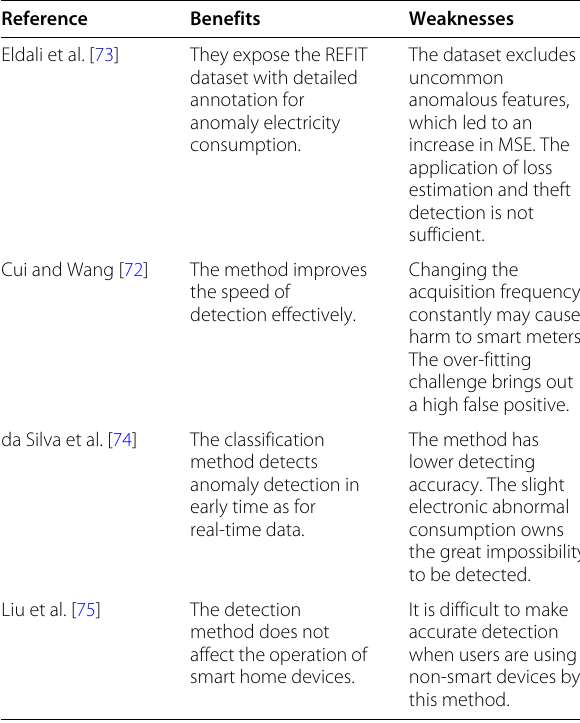
Table 5 Benefits and weaknesses of mathematical